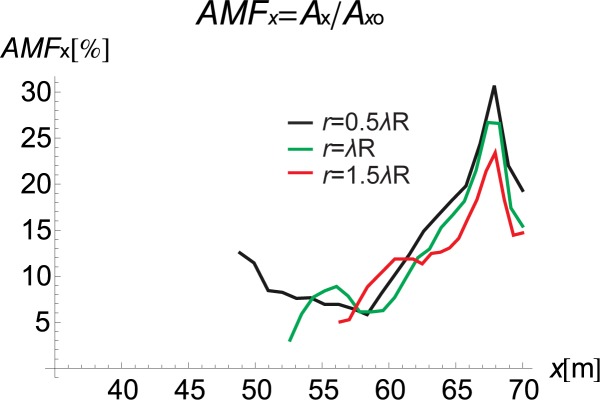
AMF for the Horizontal Displacement α = 30°: Red–r = 1.5λR, Green–r = λR, and Black–r = 0.5λR.